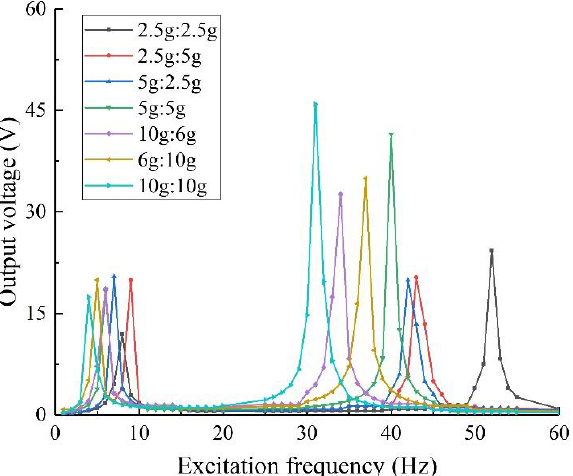
Figure 8. Harvesting performance with different mass ratios. Table 2. Output voltages with different mass